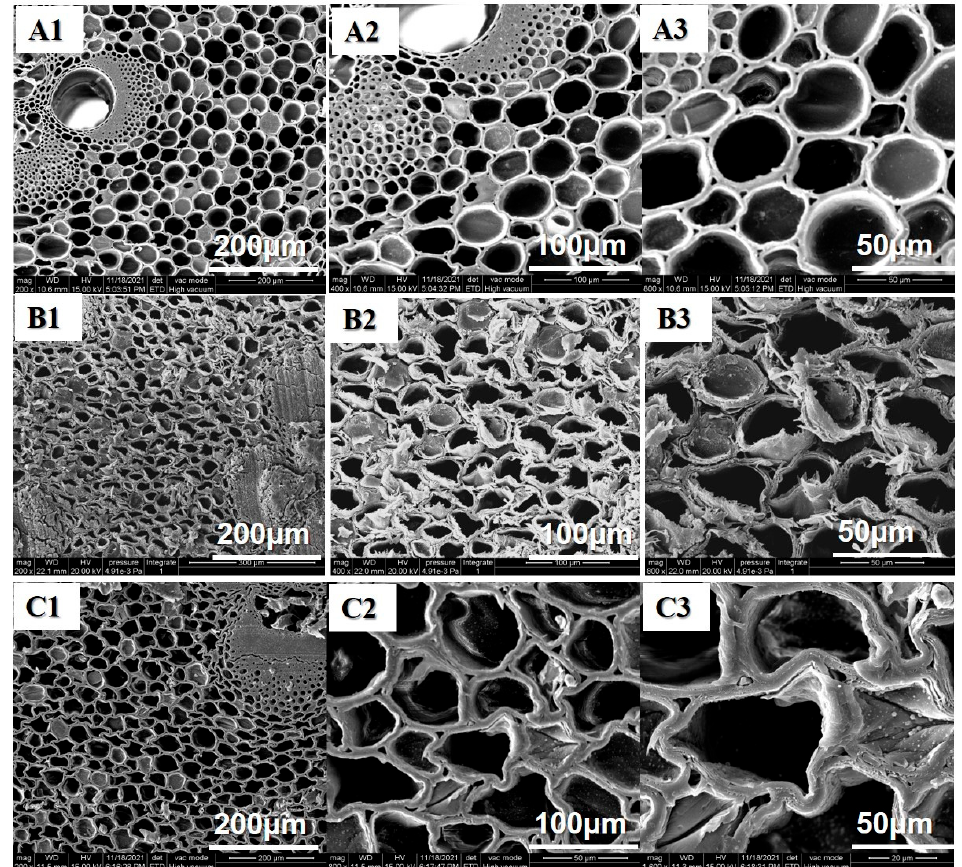
Figure 3. SEM images of different bamboo samples: ( A1 – A3 ) Untreated bamboo sample; ( B1 – B3 ) Softened treated bamboo samples (160 °C/12 min); ( C1 – C3 ) Softened treated bamboo board at 180 °C/12 min.